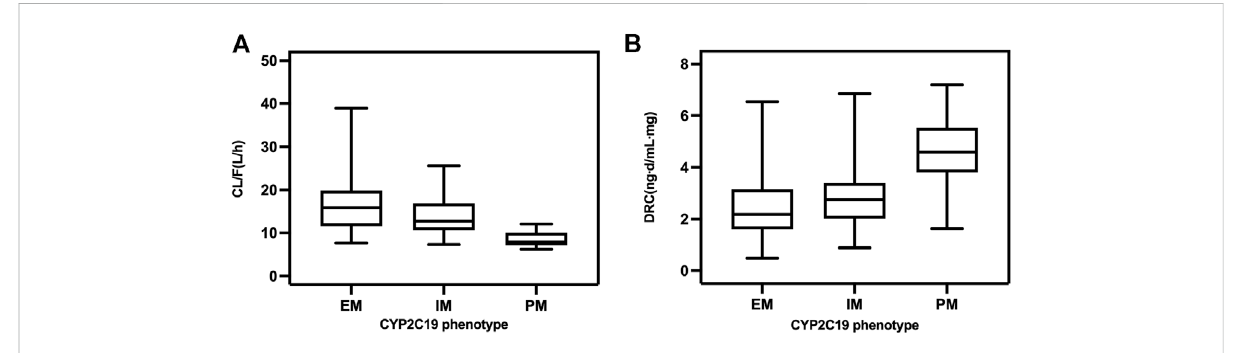
FIGURE 1 (A) CL/F and (B) DRC of escitalopram with different CYP2C19